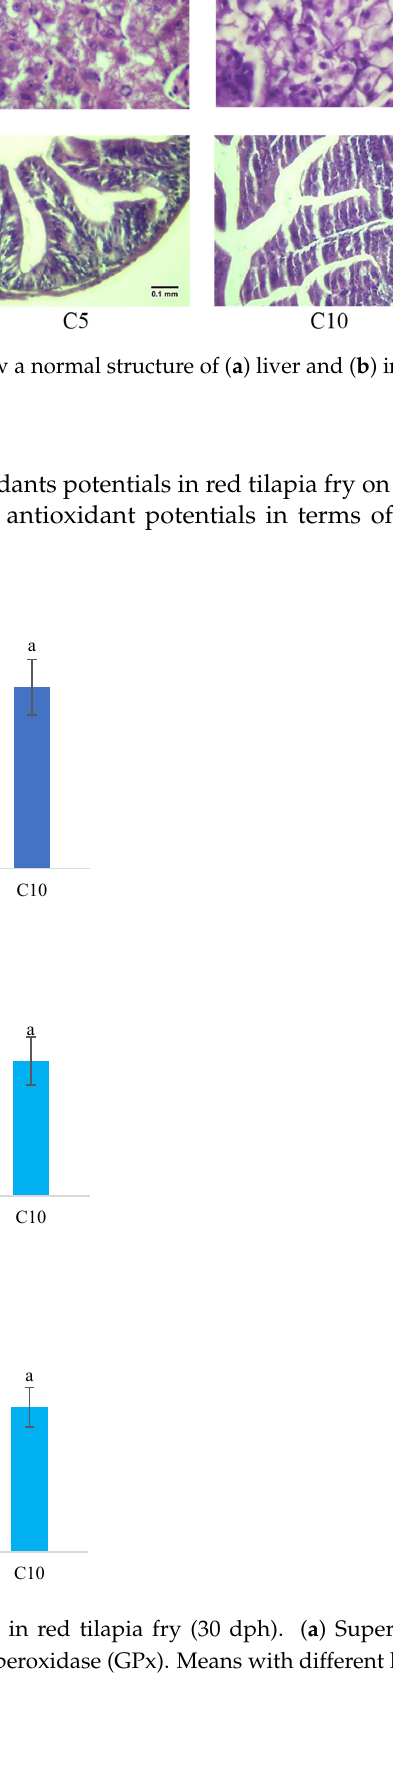
Figure 2. Histological variations ( a – f ) in the esophagus folds among trial groups. ( a , b ) Control; ( c , d ) C5; ( e , f ) C10 showing normal esophagus folds in all groups. Photos ( b , d , f ) are a magnification of ( a , c , e ), respectively (H&E staining, scale bar; 0.1 mm) . Histograms ( g , h ) illustrate the variations in red tilapia esophagus folds length ( g ) and muscularis width ( h ) among the different experimental groups. Means with different letters are different.